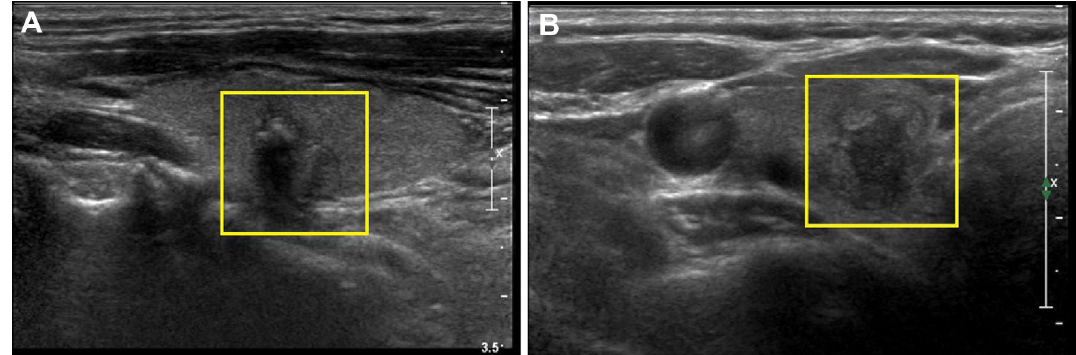
Figure 3. Deep convolutional neural network (CNN) processing using ultrasonography (US) images of malignant thyroid nodules with atypia of undetermined significance (AUS, A ) or follicular lesion of undetermined significance (FLUS, B ) results on fine-needle aspiration (FNA). ( A ) A captured thyroid US image of a yellow square region-of-interest covering the whole thyroid nodule in a 71-year-old man.